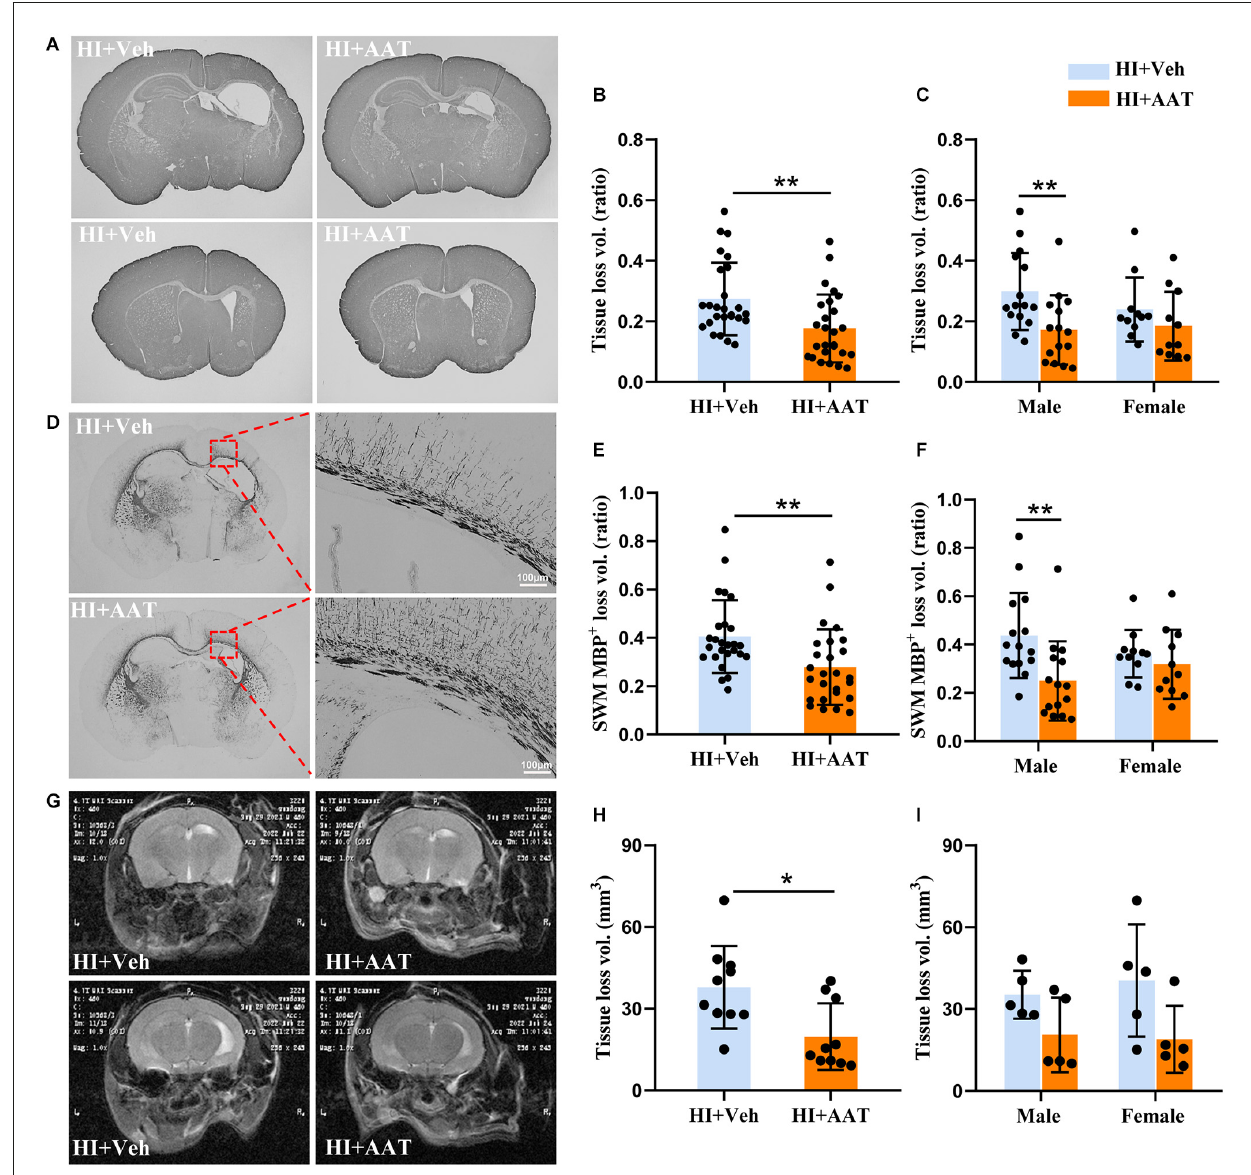
FIGURE2 AAT treatment reduced HI-induced neonatal mouse brain injury. (A) Representative MAP2 staining of coronal brain sections at the hippocampus level (upper panels) and striatum level (lower panels) at P12 after HI in the vehicle-treated and AAT-treated groups. (B) Quantification of total brain tissue volume loss ratio at P12 ( n = 26/group, p = 0.003). (C) Quantification of total brain tissue volume loss ratio at P12 in male and female mice ( n = 15/group for males, p = 0.004; n = 11/group for females, p = 0.277). (D) Representative MBP staining at the hippocampus level showing the myelin structure in the subcortical white matter at P12 after HI in the vehicle-treated and AAT-treated groups. The right panels show higher magnifications of the MBP-stained subcortical white matter in the ipsilateral hemisphere. (E) Quantification of the volume loss of MBP + subcortical white matter at P12 ( n = 26/group, p = 0.002). (F) Quantification of the volume loss of MBP + subcortical white matter at P12 in male and female mice ( n = 15/group for males, p = 0.001; n = 11/group for females, p = 0.505). (G) Representative cerebral coronal T2-weighted images at P60 after HI in vehicle-treated and AAT-treated groups. (H) Quantification of total brain tissue volume loss at P60 ( n = 10/group, p = 0.011). (I) Quantification of total brain tissue volume loss at P60 in male and female mice ( n = 5/group for males, p = 0.222; n = 5/group for females, p = 0.079). * p < 0.05, ** p <